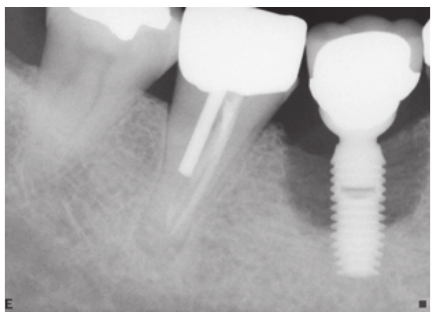
Figure 20: Peri-implant bone loss around the implant in the #30 site.